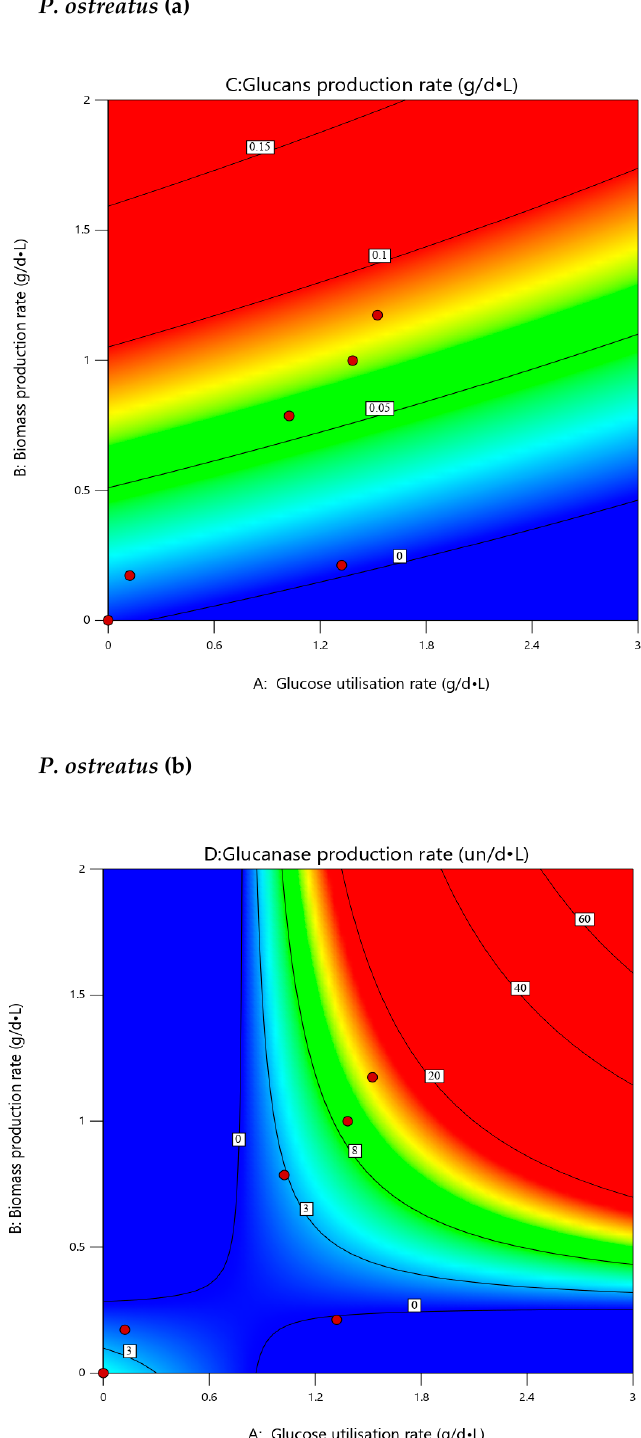
Figure 7. Contour analysis of glucans (a) and endo-1,3- β -D-glucanases (b) production of A. bisporus , A. subrufescens , P. eryngii and P. ostreatus against Glucose utilization rate (A) and the corresponding biomass-production rate (B; g: grams, d: days, L: Liter). Contour areas present glucans and glucanase production levels for different combinations of culture parameters that can determine flow and dilution rates in future continuous